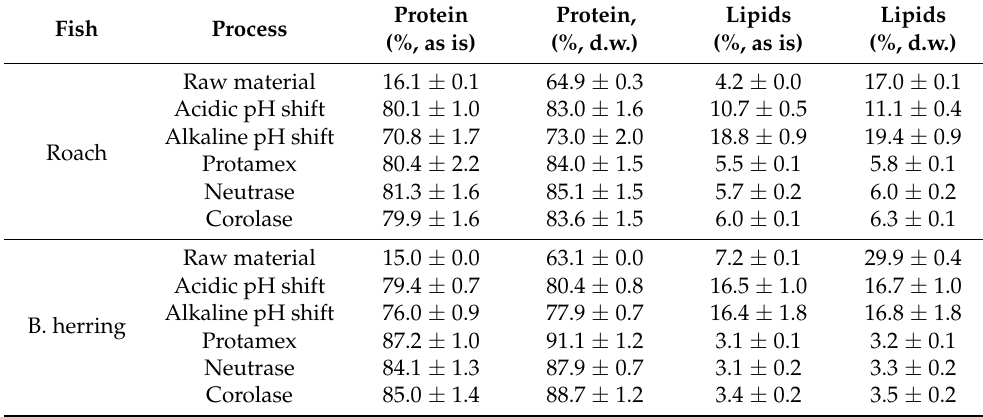
Table 1. Protein and lipid contents/wet weight (as is) and dry weight (d.w.) in raw materials and processed protein isolates and hydrolysates from roach and B. herring, adapted from Nisov et al. [29]. Protein Protein, Fish Process (%, as is) (%,